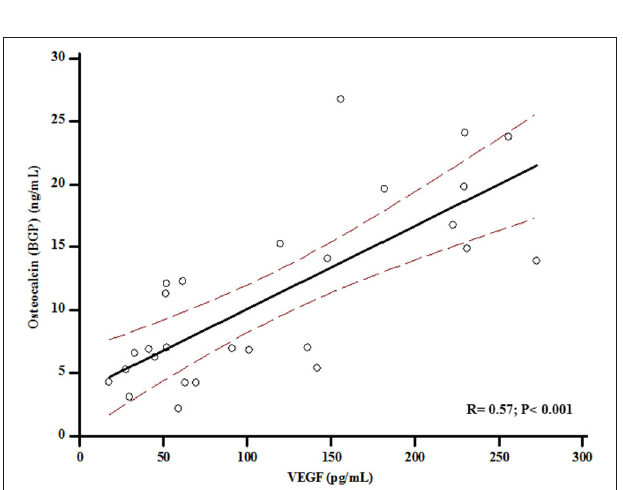
FIGURE 2 | Association between levels of Osteocalcin and Vascular Endothelial Growth Factor (VEGF) at baseline.